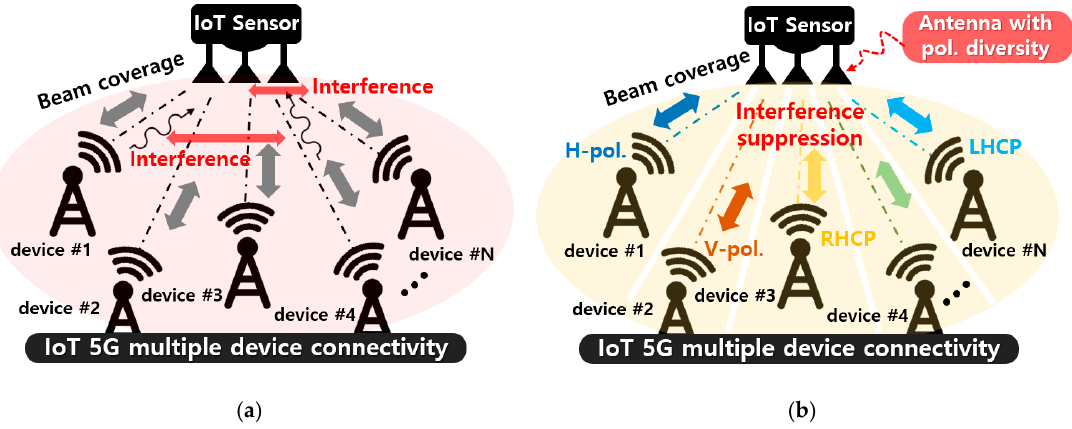
Figure 1. Multiple-input multiple-output (MIMO) communication of IoT sensors or devices through ( a ) a single polarization, and ( b ) polarization diversity (horizontal, vertical, right-hand circular, and left-hand circular polarizations).